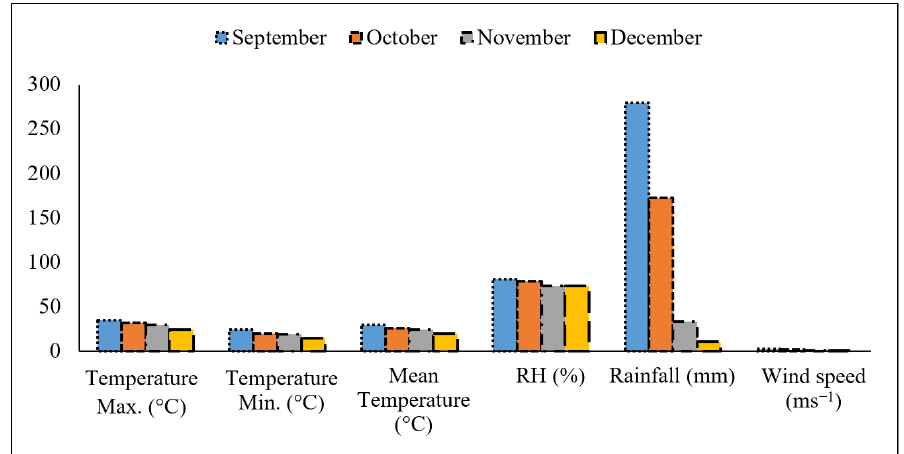
Figure 1. Monthly average air temperature (°C), rainfall (mm), relative humidity (%), and wind speed (ms − 1 ).